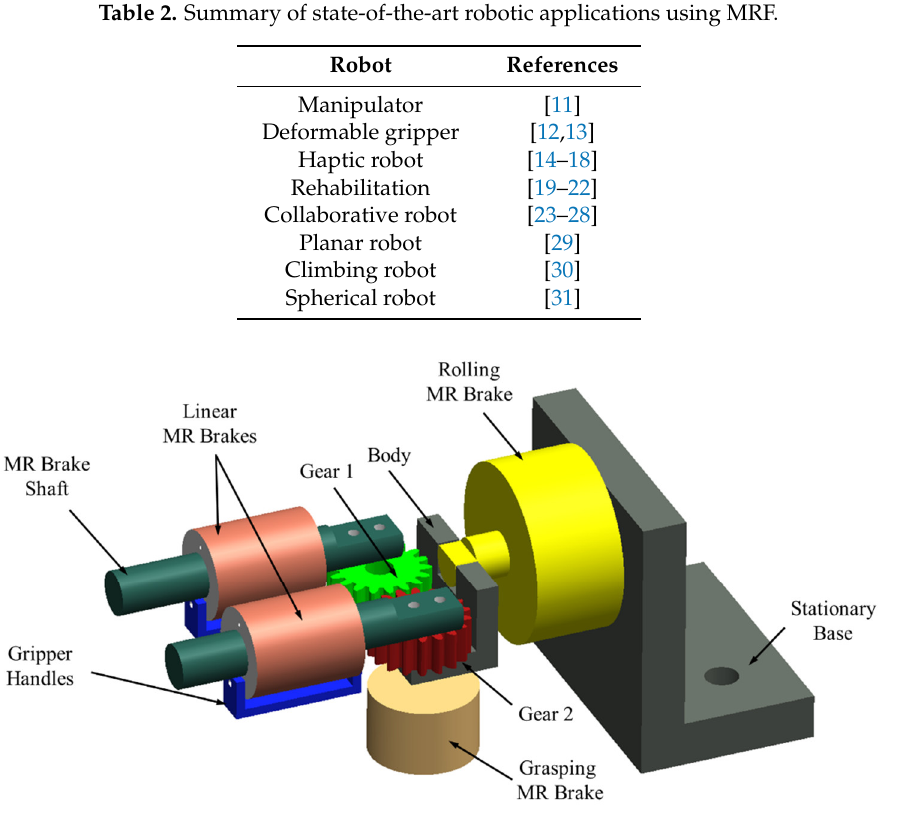
Figure 2. 3-D haptic MRF gripper for surgical robot applications [14].